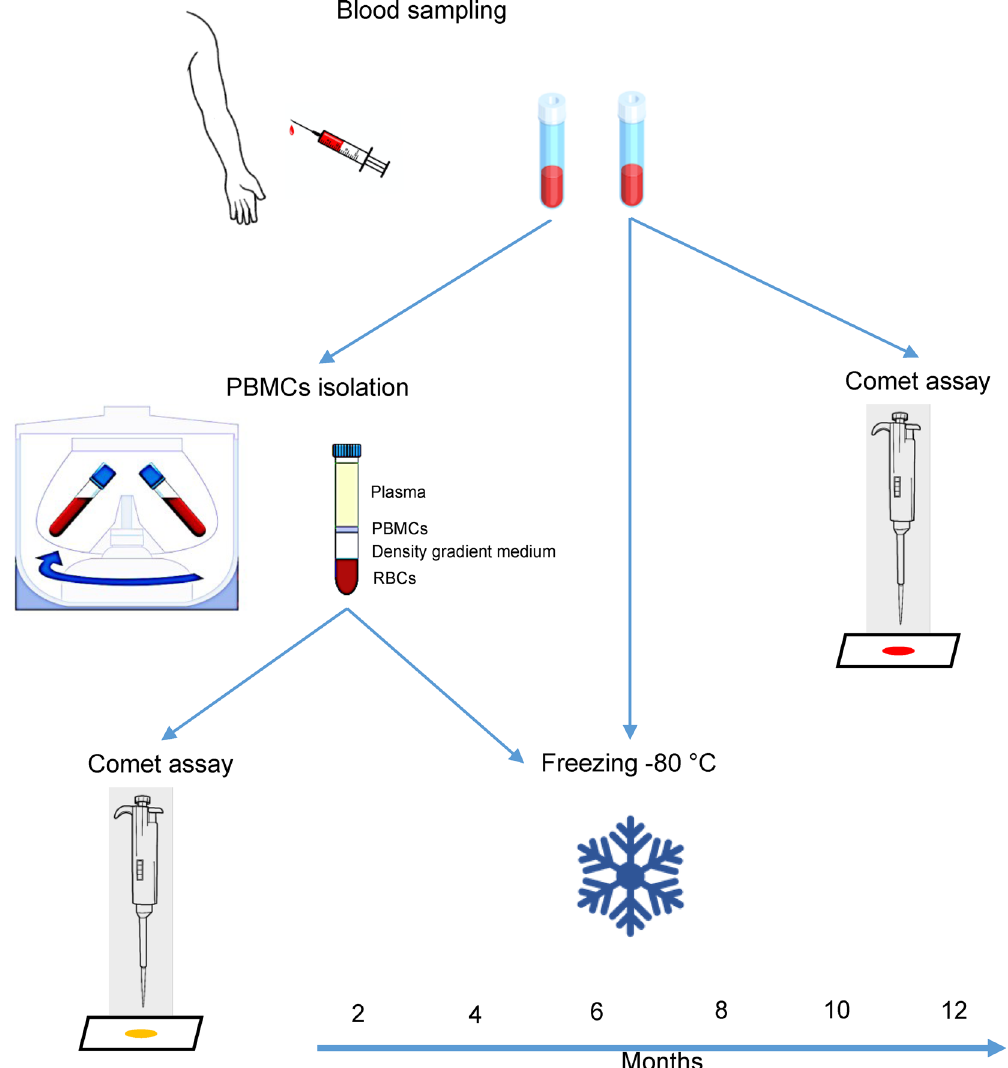
Figure 4. Experimental design. Blood is collected into two tubes containing EDTA as anticoagulant. One tube is used for the isolation of peripheral blood mononuclear cells (PBMCs) by a density gradient. Cells are washed, centrifuged and immediately used for the comet assay or aliquoted in an appropriate freezing medium and stored at − 80 °C. The second tube is used for whole blood (WB); a small aliquot (10 µL) is immediately used while the remaining samples are aliquoted in 250 µL, without cryo-preservative, and frozen. Every 2 months, comet assay is